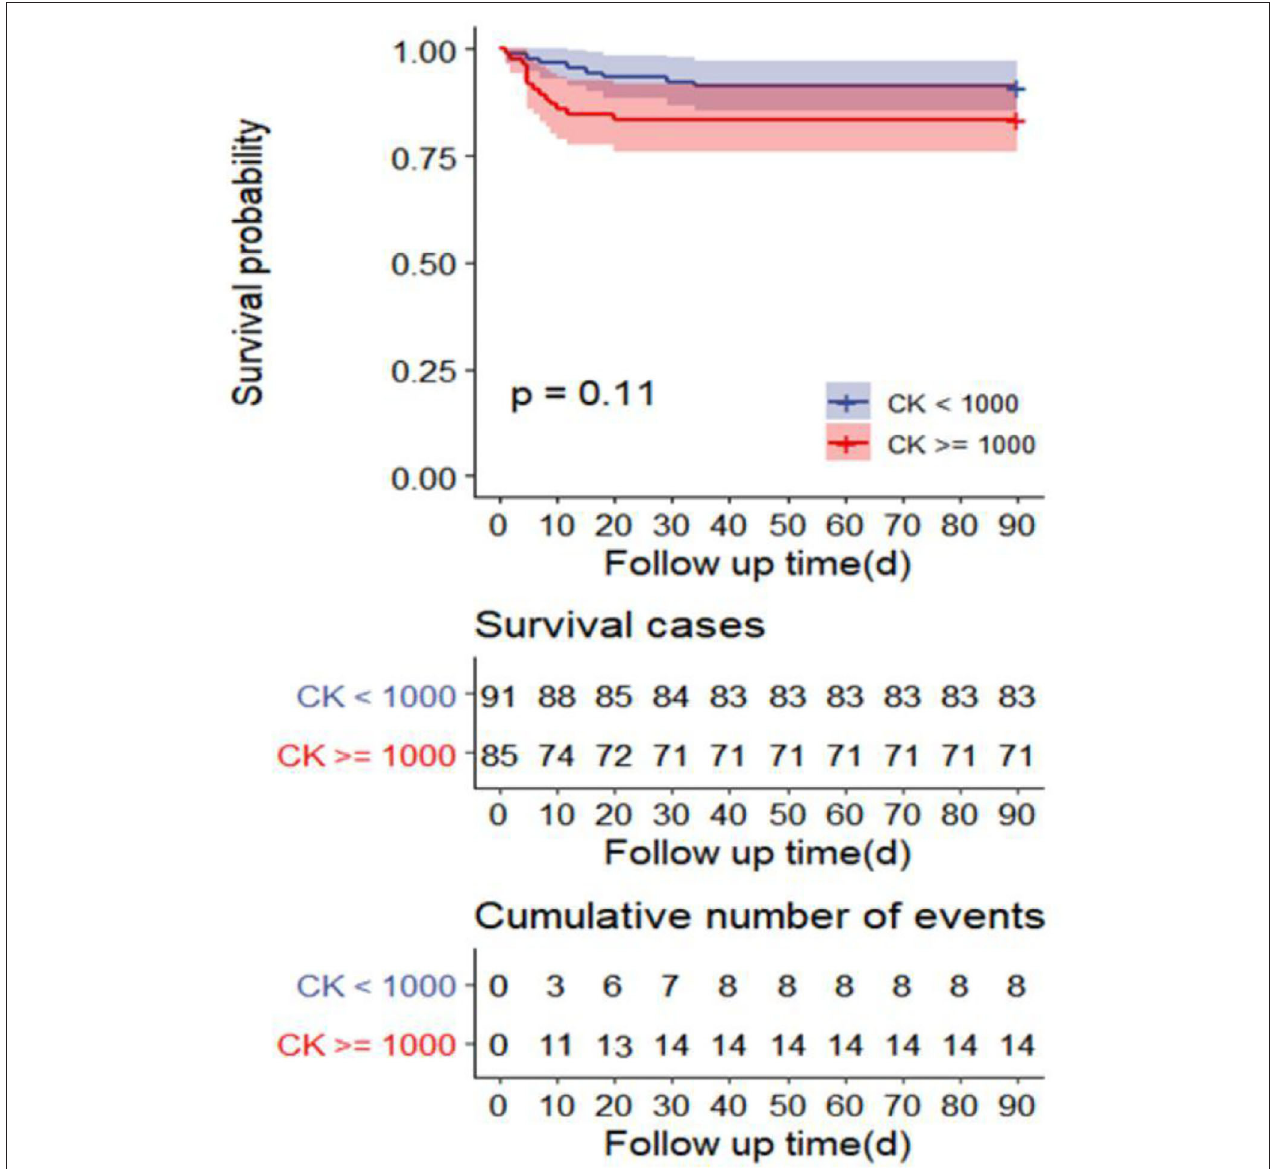
FIGURE 3 | Survival curves of 90-day mortality rate in the R) group (CK ≥ 1,000 U/L) and non-RM group (CK < 1,000 U/L). CK, creatine kinase; RM, rhabdomyolysis.